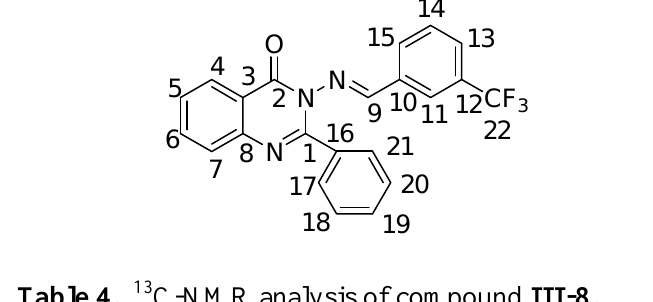
Table 4. 13 C-NMR analysis of compound